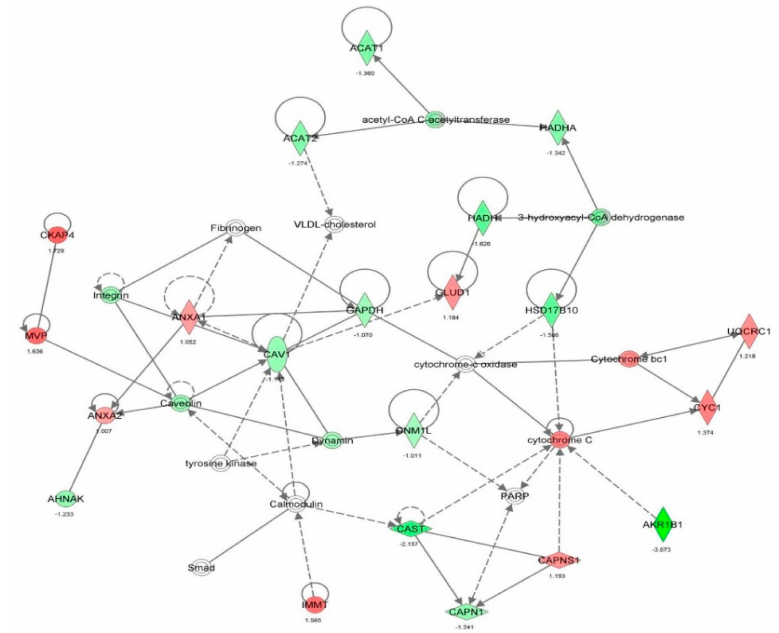
Figure 16. Vancomycin regulated endocrine system development and function, lipid metabolism, and small molecule biochemistry. Red indicates an up-regulation; green indicates a down-regulation. The intensity of green and red colors indicates the degree of down- or up-regulation. Solid arrow indicates direct interaction and dashed arrow indicates indirect interaction.